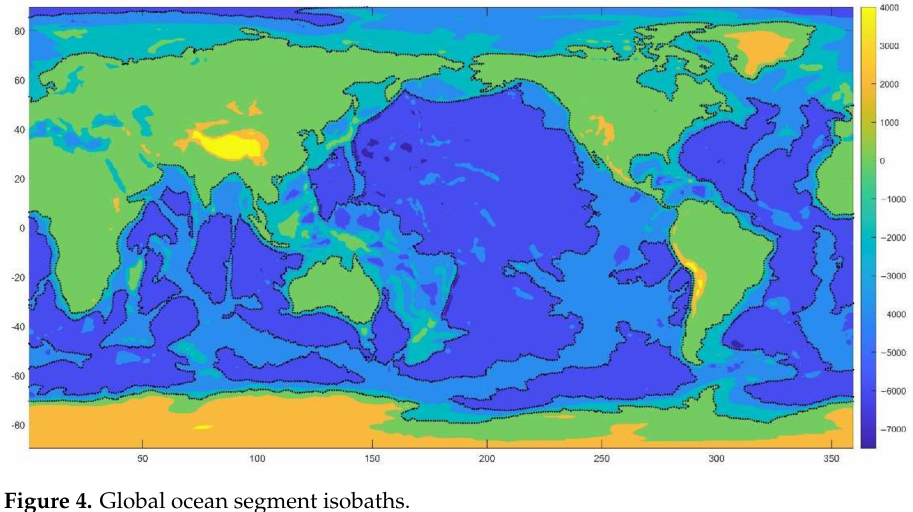
Figure 4. Global ocean segment isobaths.